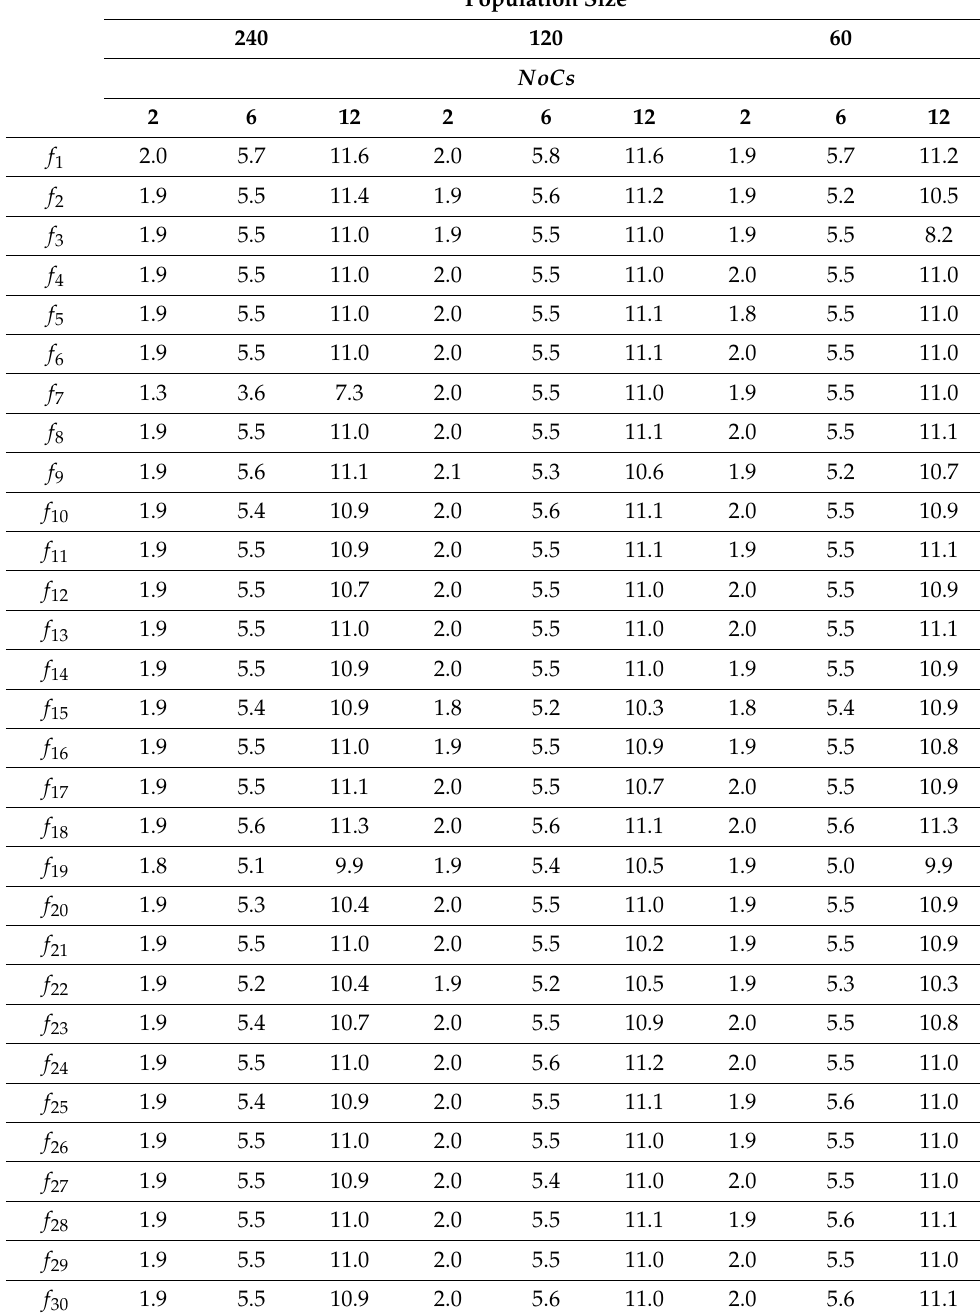
Table 6. Parallel speed-up for asynchronous parallel